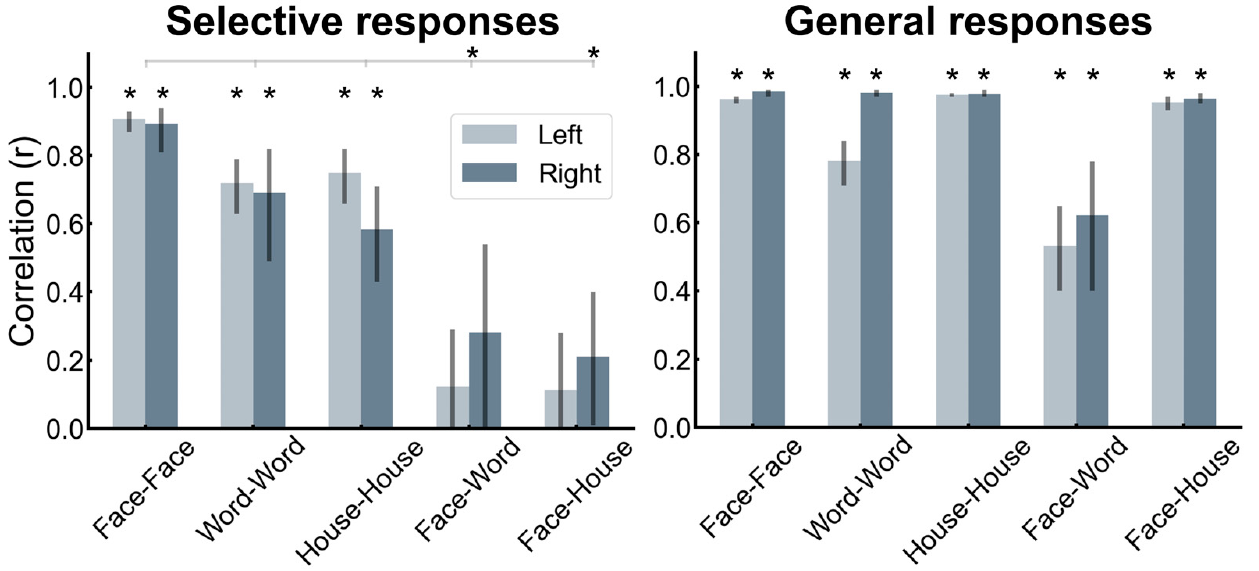
Figure 14. Left Panel: correlation values between category-selective amplitudes measured at overlapping electrode contacts either within-categories (first 3 bars; asterisk indicates correlation significantly > 0) or between faces and words (4th bar) showing little to no correlation (no higher than faces and houses, 5th bar) for these two categories. These low correlation values are statistically lower than within-categories correlation values). The high within-category correlation also illus- trates the high test-retest reliability of these measures (especially for face-selective activity across two stimulation sequences only). In all conditions, the general visual responses ( right panel) are also highly correlated (except for faces and words, with very different stimuli appearing at the base rate: objects and pseudofonts, respectively) [168].